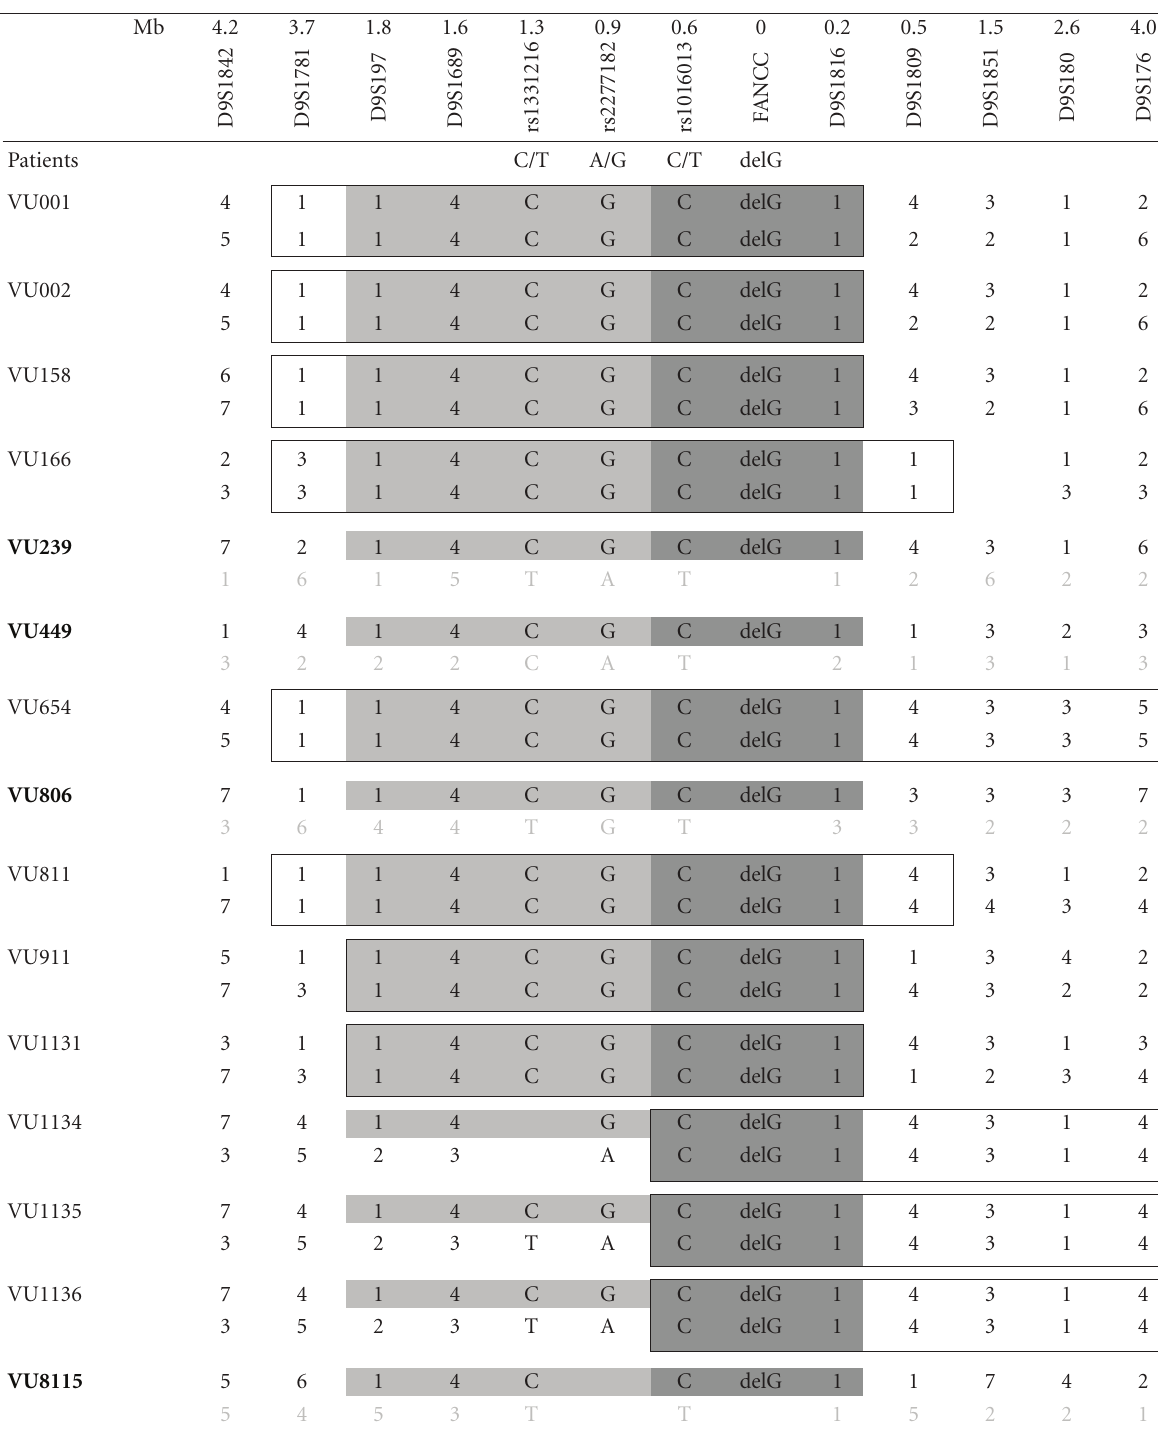
Table 1: The haplotype associated with the FANCC c.67delG mutation determined in 15 patients of Dutch ancestry (Table 1(a)) and in the a ff ected sib of the proband, the parents, and healthy sibs of the Mennonite kindred (Table 1(b)). In Table 1(a) simplified, deducted allele lengths are shown and in Table 1(b) the observed allele lengths are shown. For comparison, patient VU1135 is included in both tables. The dark grey boxes shows the smallest common haplotype of 0.8Mb. The light and dark grey box, together show the larger common haplotype of 2 Mb. The boxed areas indicate homozygosity for the relevant markers. At the top, the distances in Mb of the markers to the c.67delG mutation are indicated. Patients VU001 and VU002 are siblings as well as patients VU1134, VU1135, and